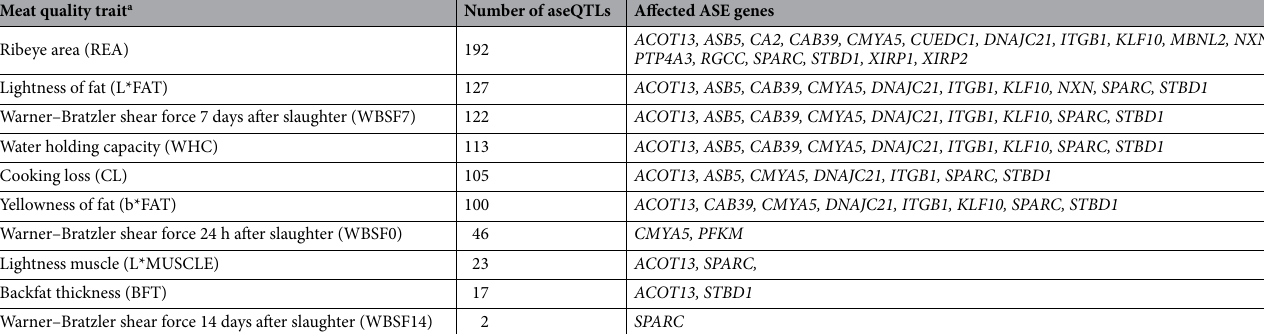
Table 1. Allele-specific expression quantitative trait loci (aseQTLs) overlapping meat quality traits identified in Nelore muscle and allele specific expression (ASE) genes affected by aseQTLs.